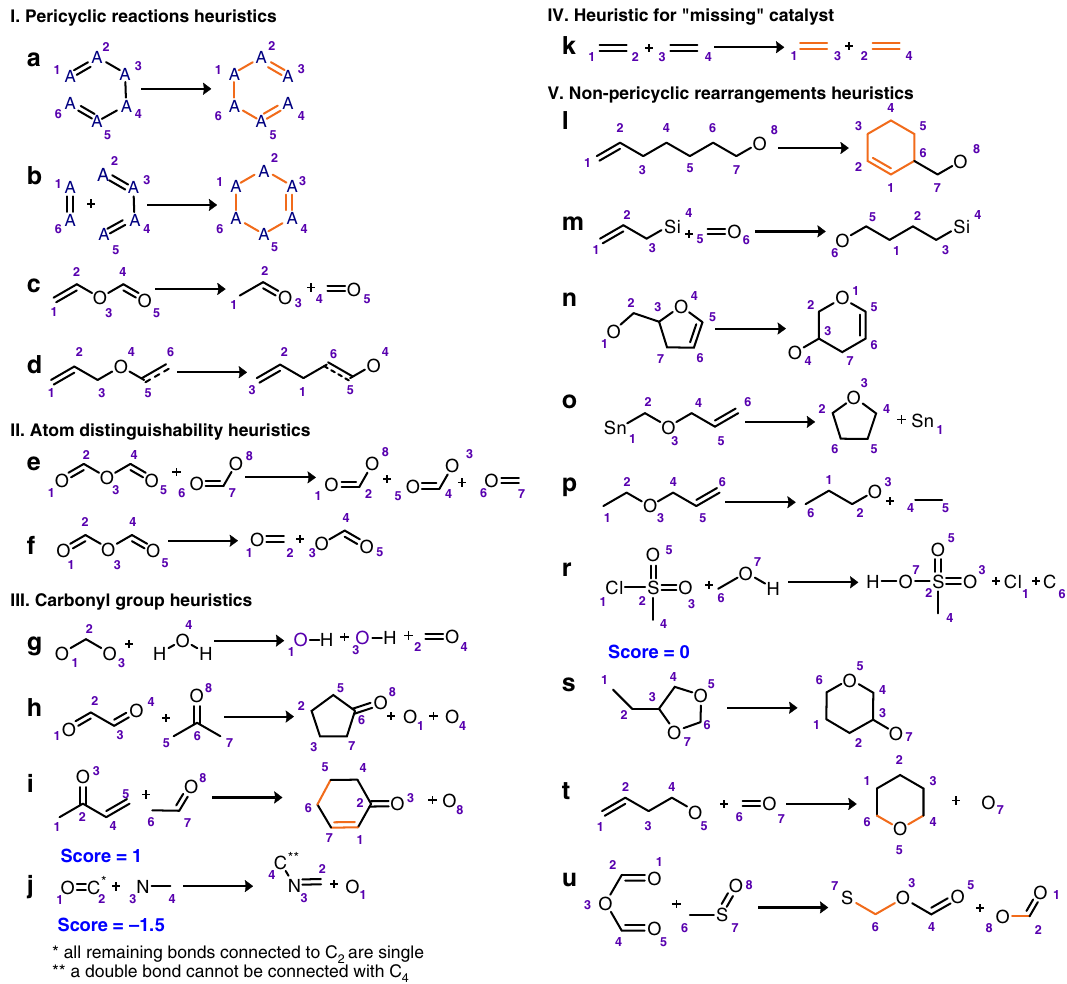
Fig. 2 Schemes of reaction heuristics guiding the searches. Speci fi c heuristics span various reaction classes: a – d pericyclic reactions; e , f reactions in which two atoms of the same type can be hard to distinguish due to symmetry; g – j select reactions involving carbonyl group; k reactions such as metathesis; l –